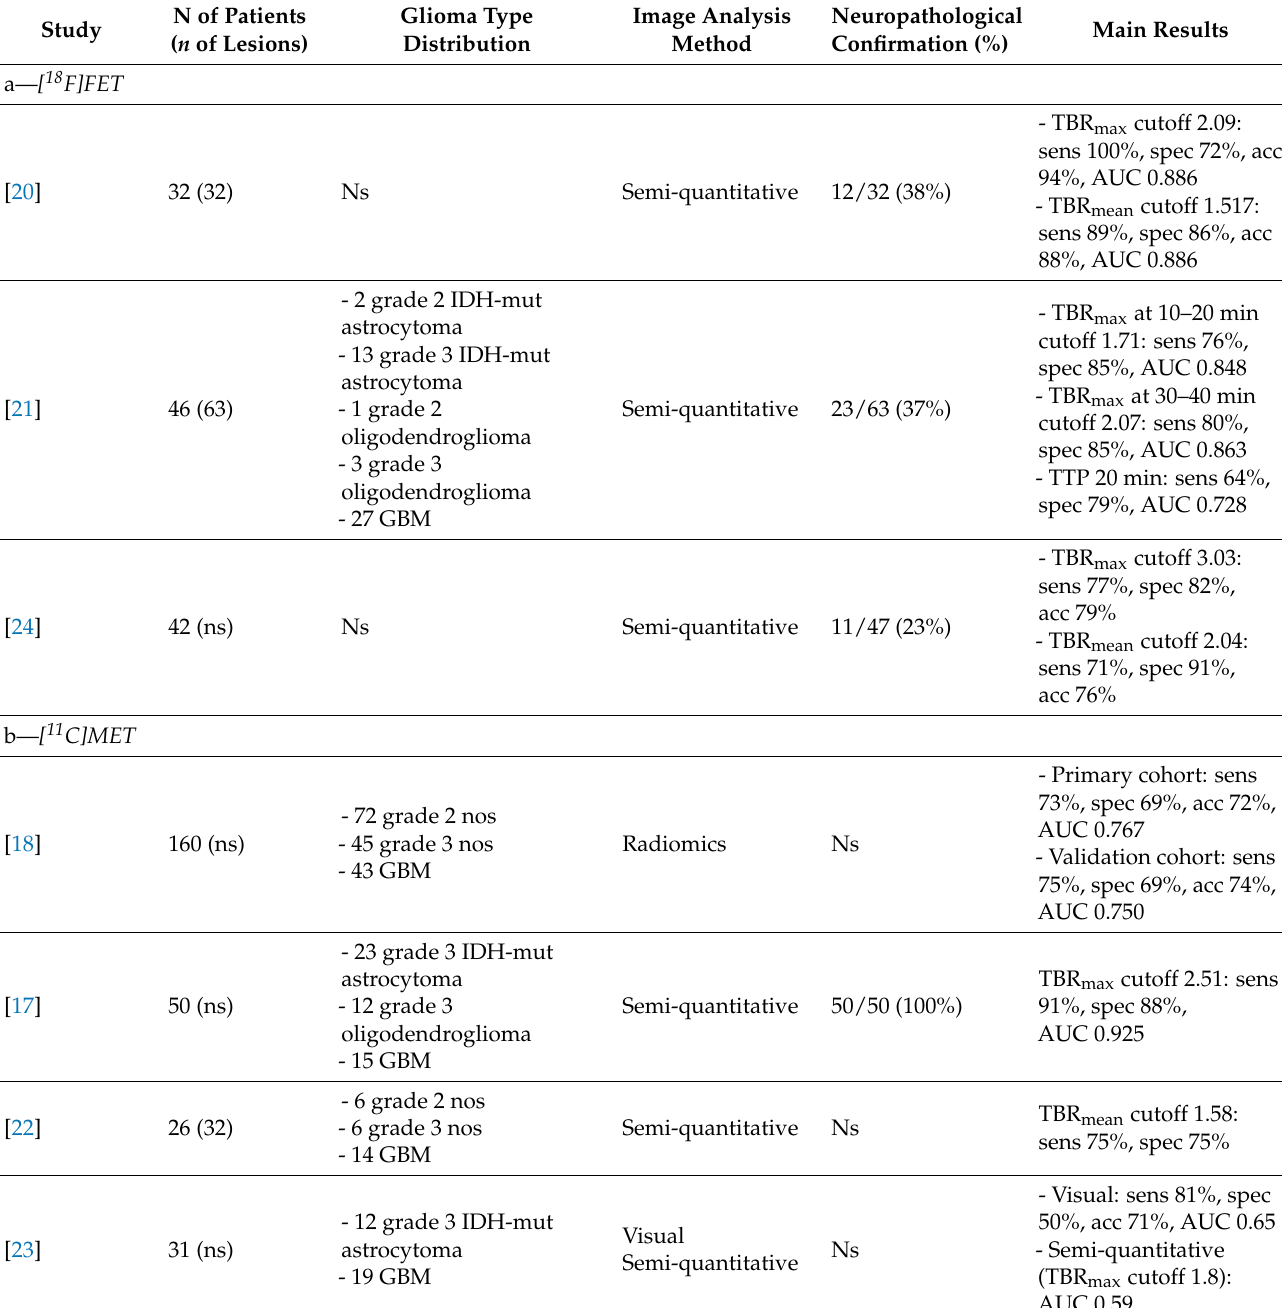
Table 3. Summary of studies investigating the diagnostic accuracy of [ 18 F]FET and [ 11 C]MET